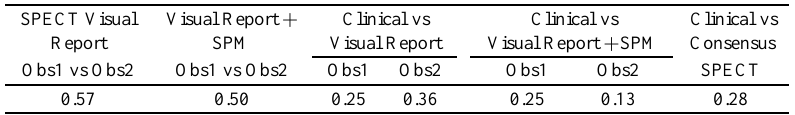
Table 4 Measured agreements – Kappa